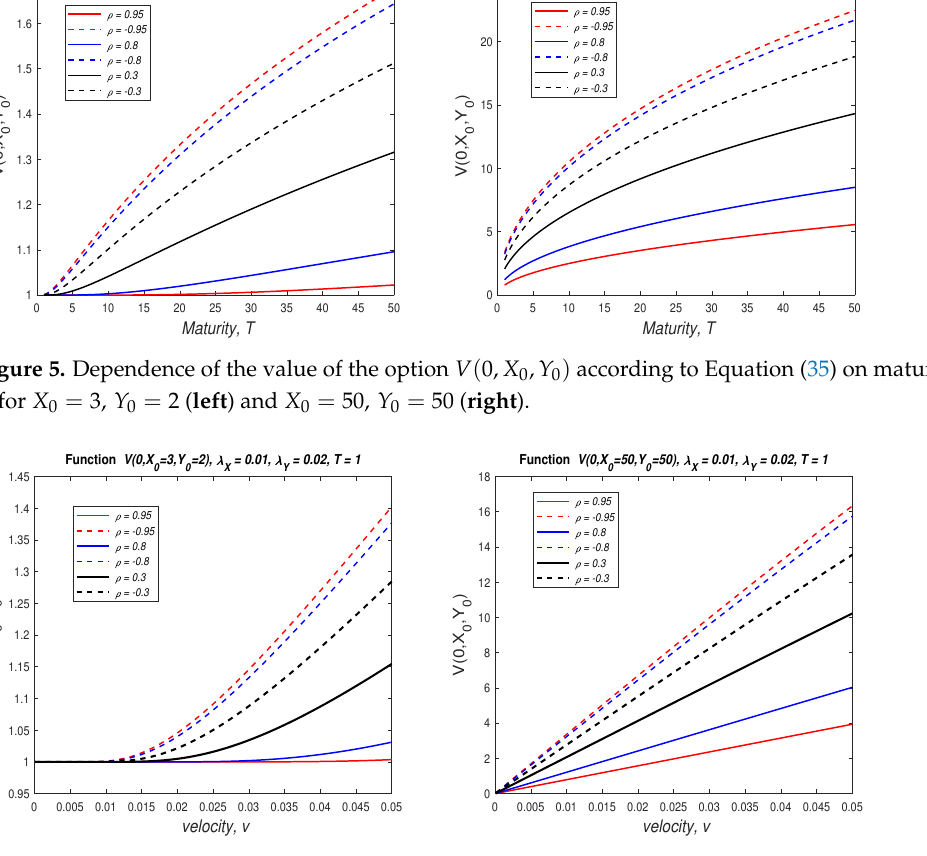
Figure 6. Dependence of value of the option V ( 0, X 0 , Y 0 ) according to Equation (35) on velocity v for X 0 = 3, Y 0 = 2 ( left ) and X 0 = 50, Y 0 = 50 ( right ).